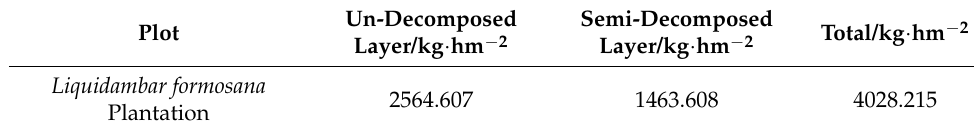
Table 4. Litter layer storage [21].